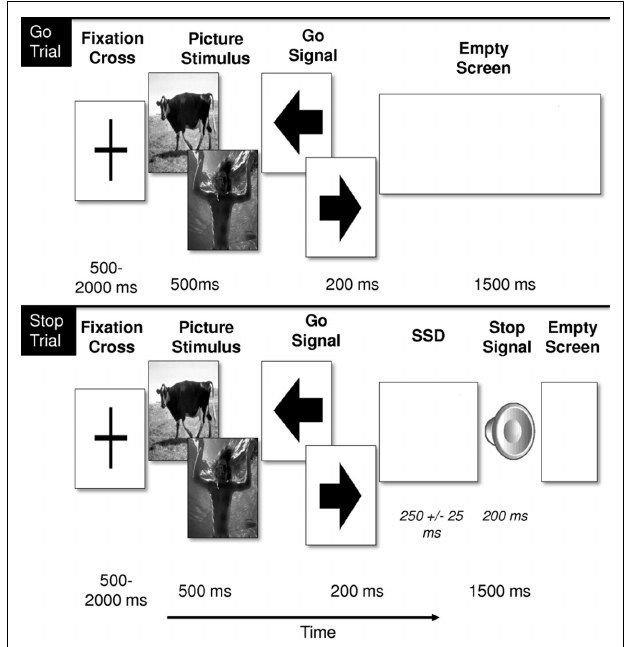
FIGURE 1 | Schematic design of the Go and Stop trials. Both trials started with a fixation cross, followed by a picture stimulus (neutral or negative). Next a left or right pointing arrow was presented (Go-signal). Each trial ended with a blank screen during which participants could give a response. On the Stop trials, the Go-signal was followed by an auditory Stop-Signal after a stop-signal delay